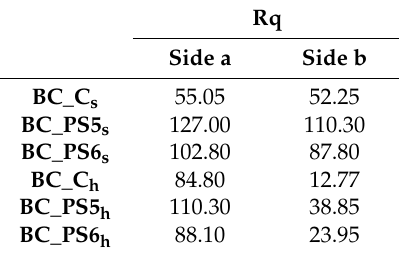
Table 3. Roughness values, obtained with AFM, of pure BC and its composites.